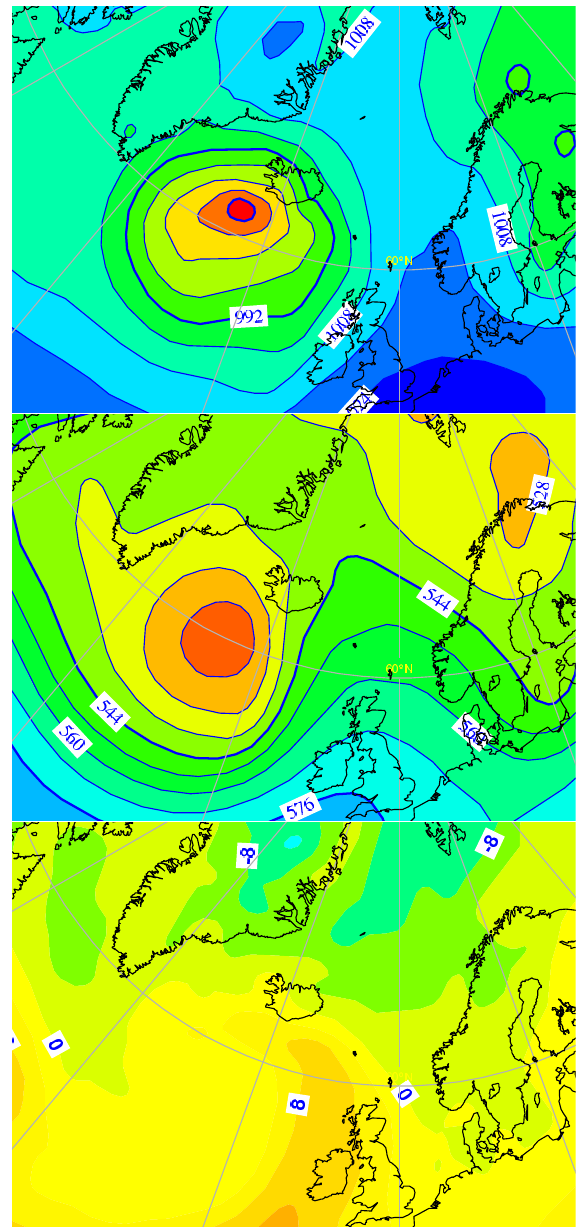
Figure 1: Mean sea level pressure [hPa] (top), geopotential height at 500 hPa Fig. 1. Mean sea level pressure [hPa] (top), geopotential height at [m] (middle) and temperature at 850 hPa [ ◦ C] (bottom) on 16 September 2004 at 500hPa [m] (middle) and temperature at 850hPa [ ◦ ] (bottom) on 16 0600 UTC. Based on the operational analysis provided by the ECMWF. September 2004 at 06:00UTC. Based on the operational analysis provided by the